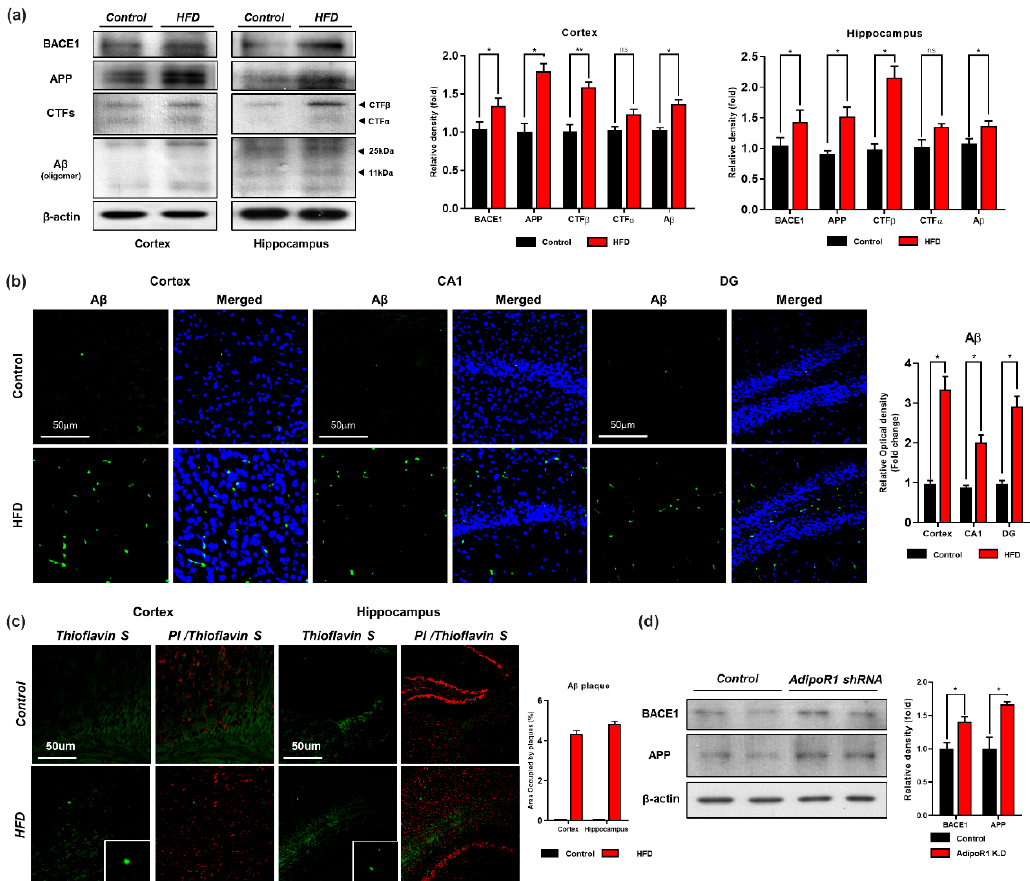
Figure 5. Chronic HFD up-regulates the amyloidogenic pathway in HFD mouse brain. ( a ) Represents the expression level of beta-amyloid-cleaving enzyme (BACE-1), amyloid precursor protein (APP), APP-C-terminal fragment β eta (APP-CTF β ) and amyloid beta (A β ) proteins via western blot. β -actin was used as a loading control. ( b ) Given are the representative images of Immunofluorescence staining of A β in the cortex and hippocampal (CA1 and DG region) of the HFD mice brain (n = 12 mice / group) ( c ) Thioflavin S staining representing the sign of early plaque deposition in the cortex and hippocampus region of control and HFD mice brain. ( d ) Western blot analysis indicating expression level of BACE-1 and APP proteins in control and AdipoR1 knockdown in embryonic mouse hippocampal cell line mHippoE-14 (AdipoR1 shRNA). Data are presented as mean ± SEM. Data for immunofluorescence and western experiment are compared using the Student’s t -test and other data are compared using one-way ANOVAs. Data are compared using U \ the unpaired Student’s t -test. Significance = * p < 0.05, ** p < 0.01. n.s =